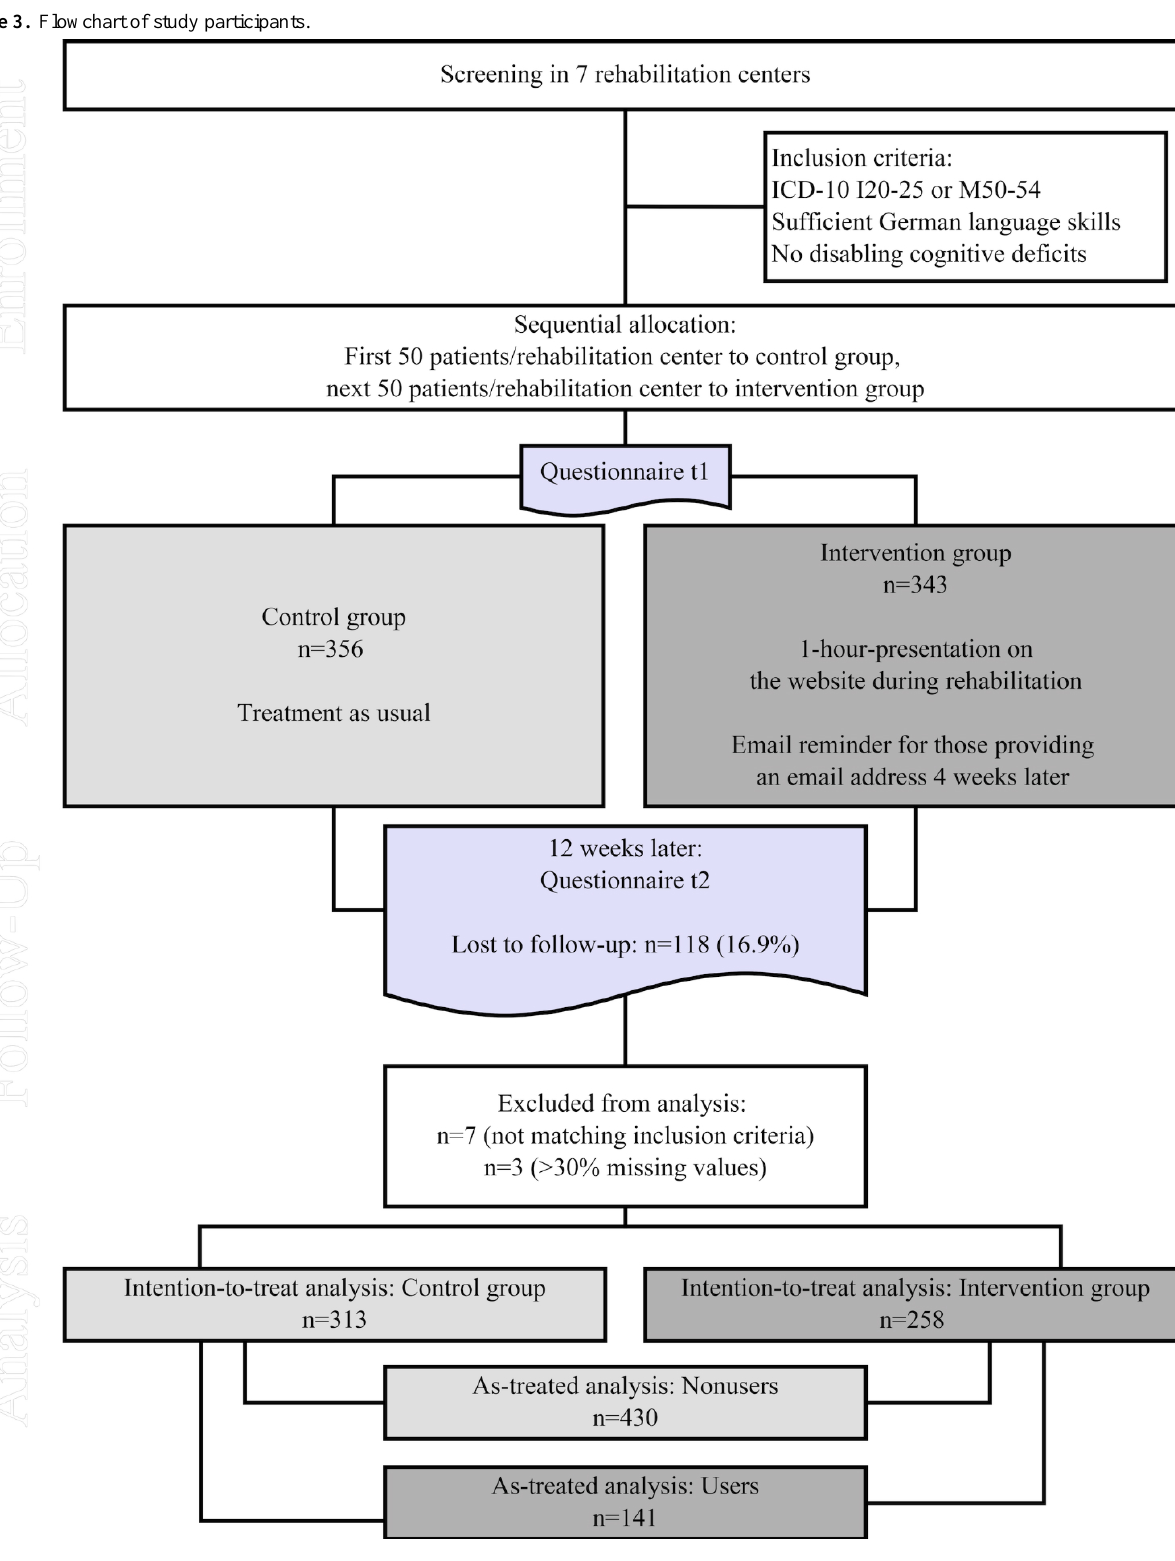
Figure 3. Flowchart of study